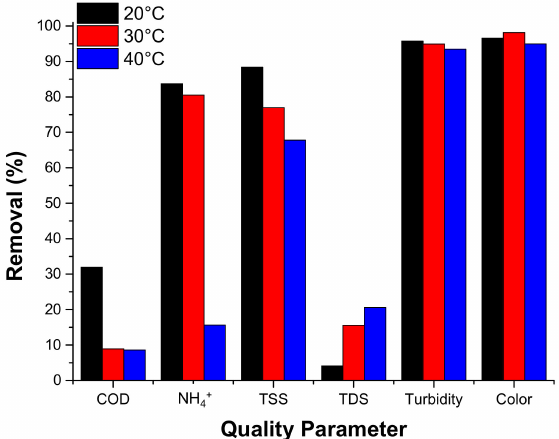
Figure 7. The effect of temperature on the removal rate of COD, NH 4 + , TDS, TSS, turbidity, and color (pH = 7.5; current density = 64 mA/cm 2 ; inter-electrode distance= 1.5 cm; electrolysis time = 120